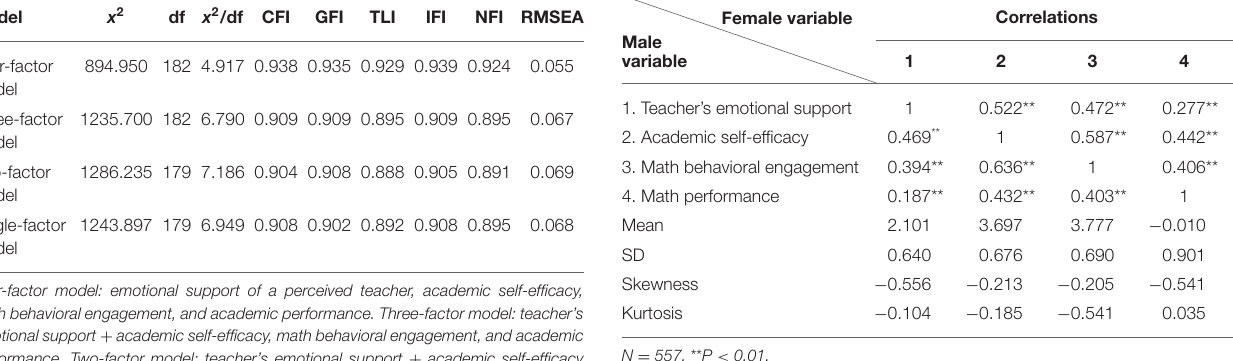
TABLE 1 | Confirmatory factor analysis results of variable discriminant validity. Model